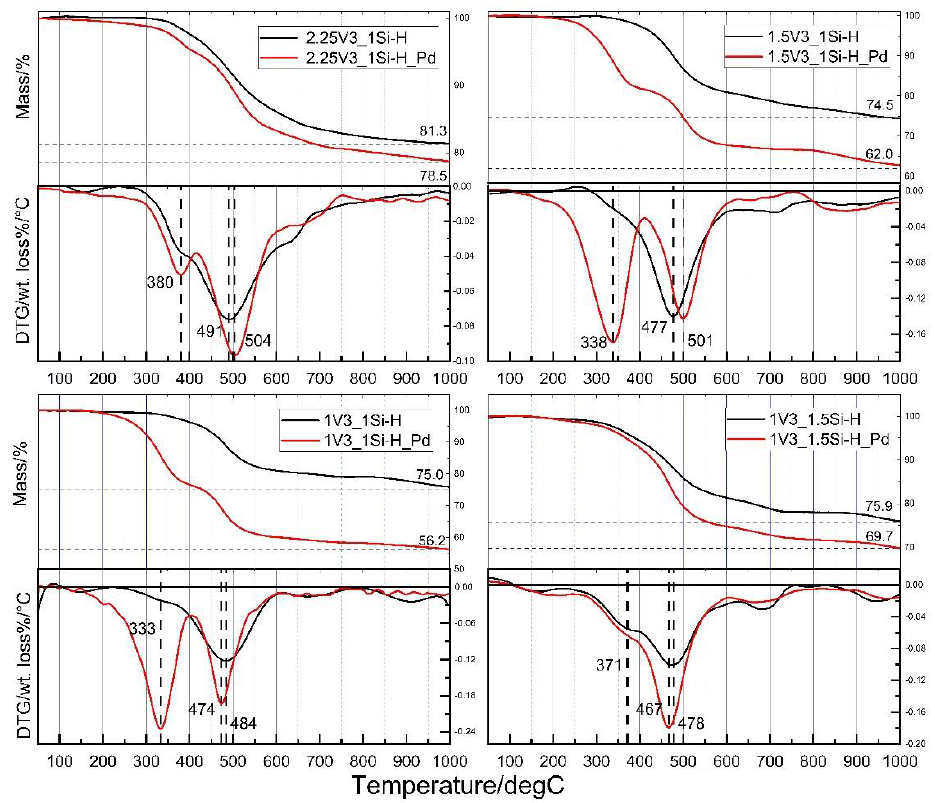
Figure 6. TG and derivative TG (DTG) curves obtained for the initial and Pd-containing V 3 polymer- based polyHIPEs studied in the work. based polyHIPEs studied in the